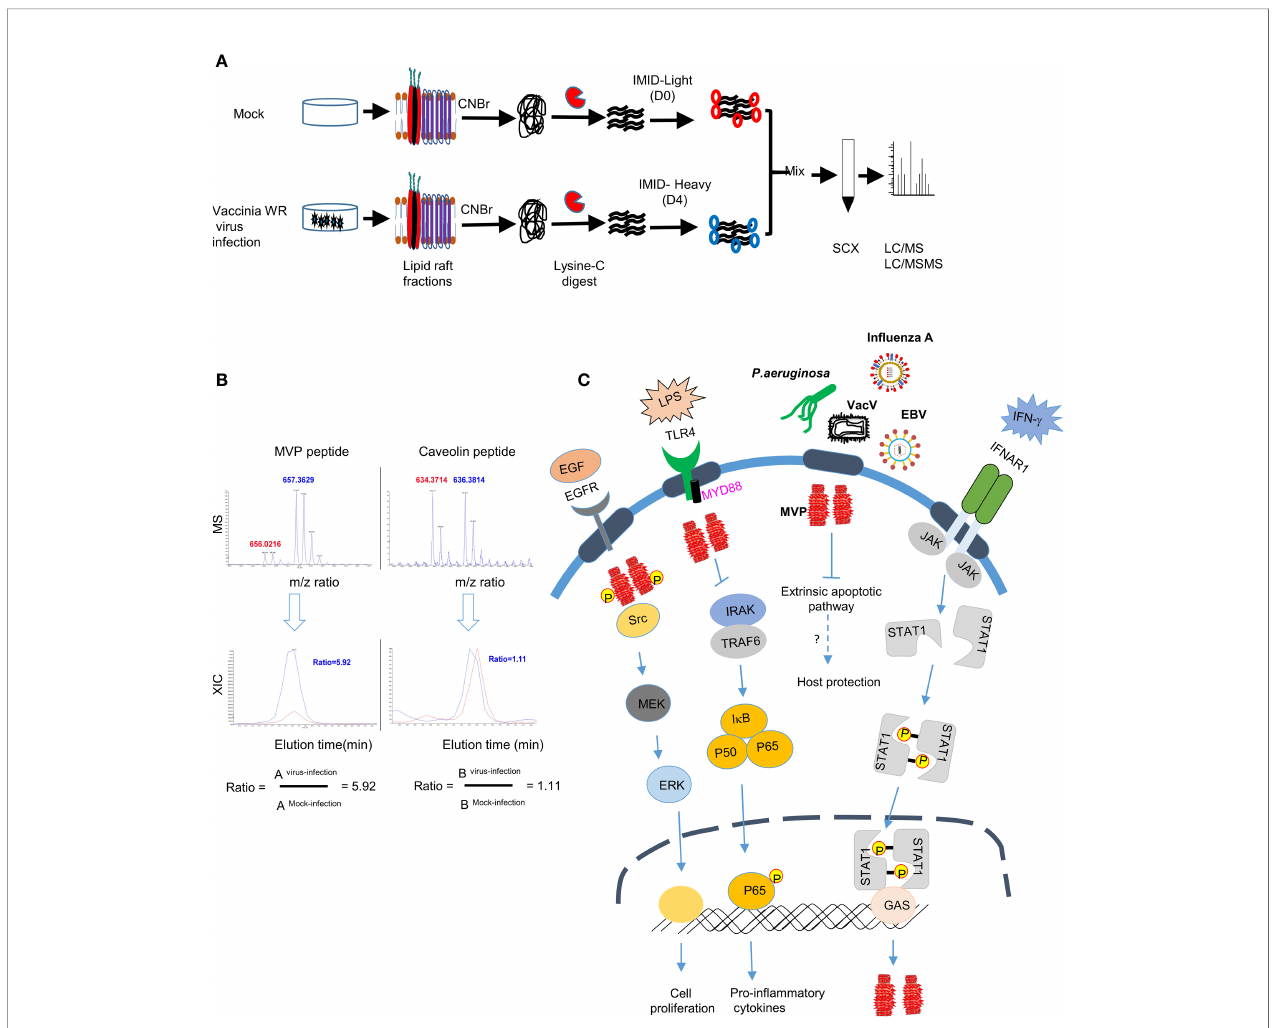
FIGURE 2 | MVP accumulates in lipid rafts after infection with vaccinia virus (A) Schematic representation of differential IMID-H4/D4 labeling and LC/MS/MS analyses of lipid raft-associated proteins isolated from HeLa cells that were either mock infected or infected with WR strain MV as previously described (66, 67). (CNBr, Cyanogen bromide, SCX, Strong cation exchange column, m/z, mass-to-charge ratio), (B) Differential protein association in lipid raft proteome derived from mock or vaccinia virus infected HeLa cells (66). Labelled peptides were quantitatively determined by lysine-speci fi c isotope labeling scheme. Co-eluted peaks contained peptides from both virus infected cells (blue) and from mock-infected cells (red). The blue-to-red ratio determined whether abundance of one particular peptide after virus infection is increased (>1), unchanged (=1) or decreased (<1). (C) Role of MVP in signaling pathways: MVP protein, the major component of vault particle, is recruited to the lipid rafts upon stimulation with growth factors (e.g., EGF) or pathogen derived ligands (e.g., LPS) and regulates important biological processes such as cell proliferation and cytokine secretion. IFNAR receptor stimulation with IFN- g in the lipid rafts activates JAK-STAT signaling pathway which in turn will lead to the transcription of MVP. MVP also plays an important role in regulating apoptotic signaling pathway on infection with pathogens such as P. aeruginosa and helps in host protection, however the detailed mechanism on how recruitment of MVP to the lipid rafts after infection with other pathogens such as VacV, EBV and in fl uenza virus needs